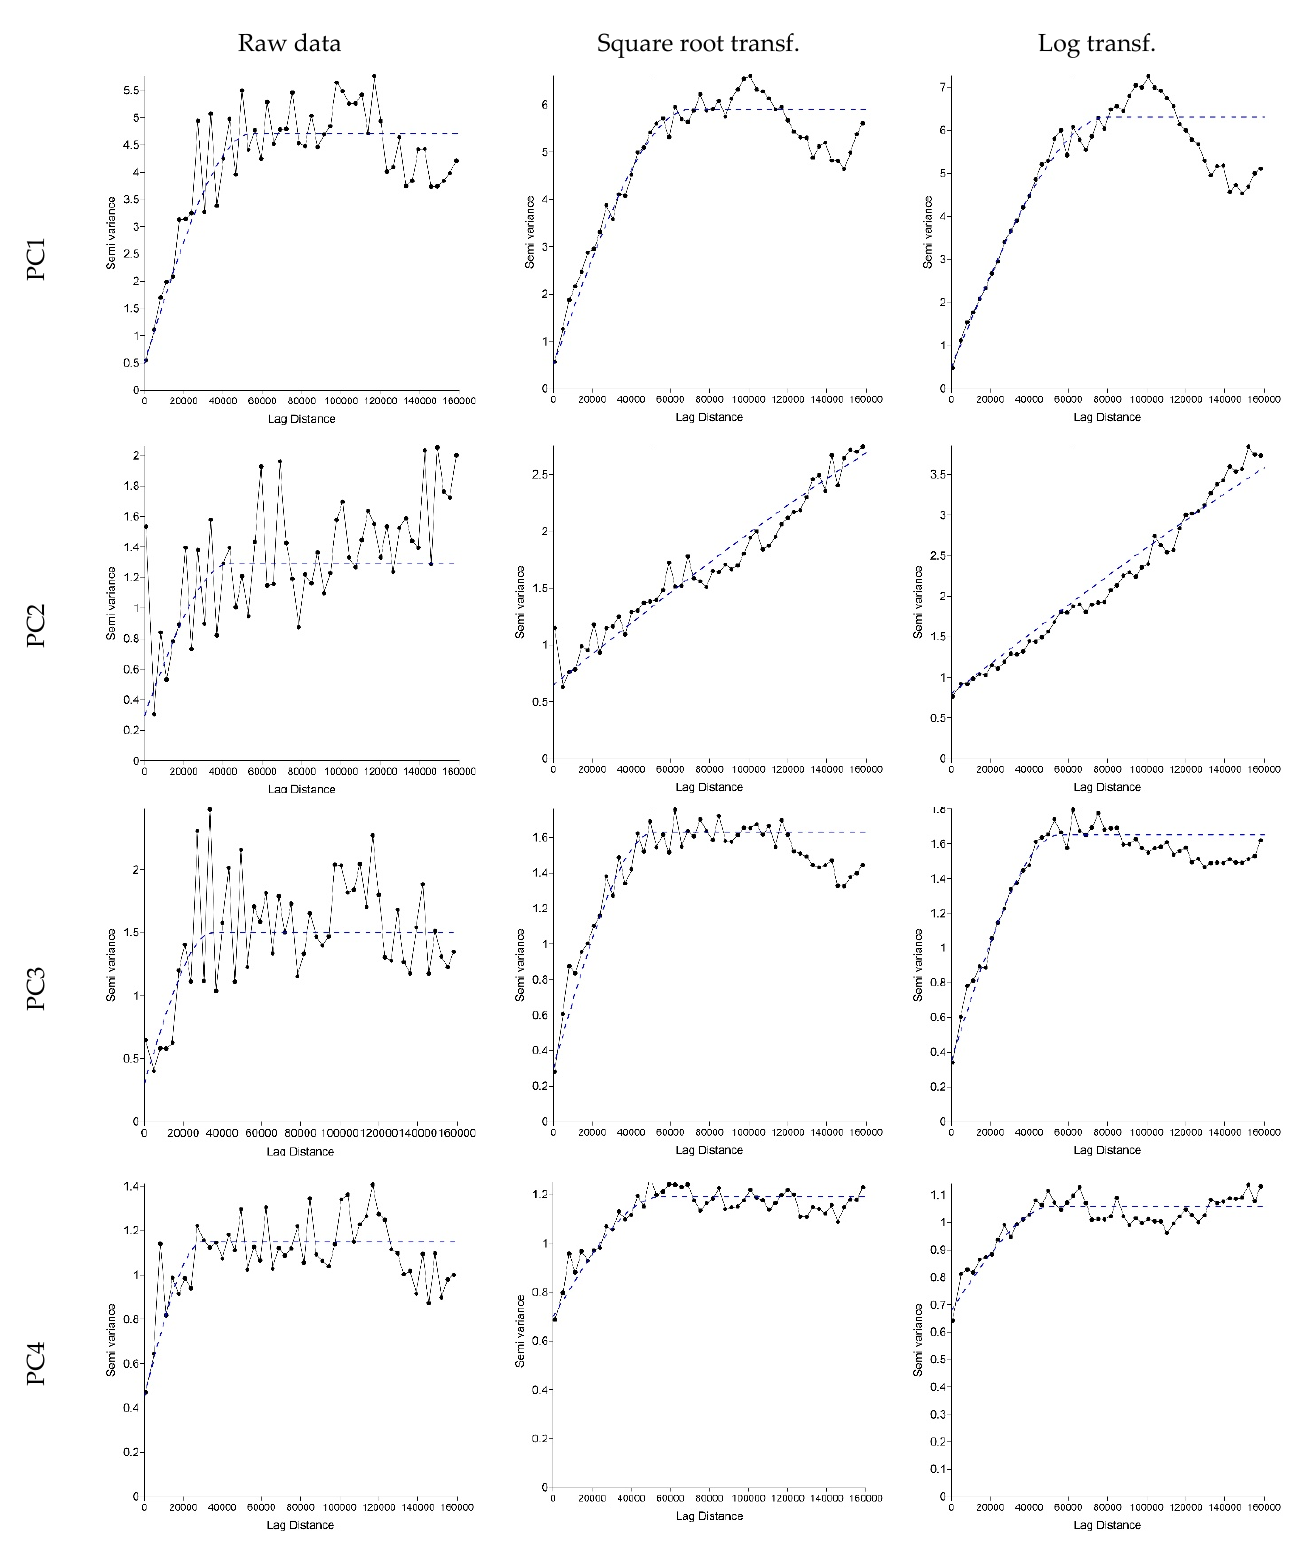
Figure 6. Experimental variograms and fitted spherical models for PC1 to PC4 (distance in m). Table 4. Characteristics of the spherical models fitted on the experimental variograms. Raw Data Square Root Transf.